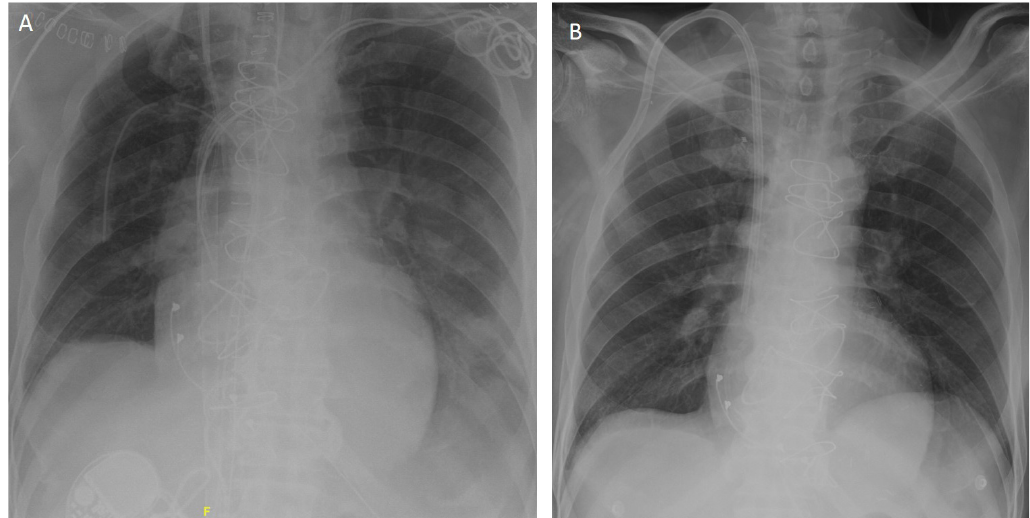
Fig. 3 – (A) Chest radiography after triple valve surgery, with remaining lead fragments and venous ECMO cannula in the right atrium. (B) Chest radiography after lead extraction and ECMO